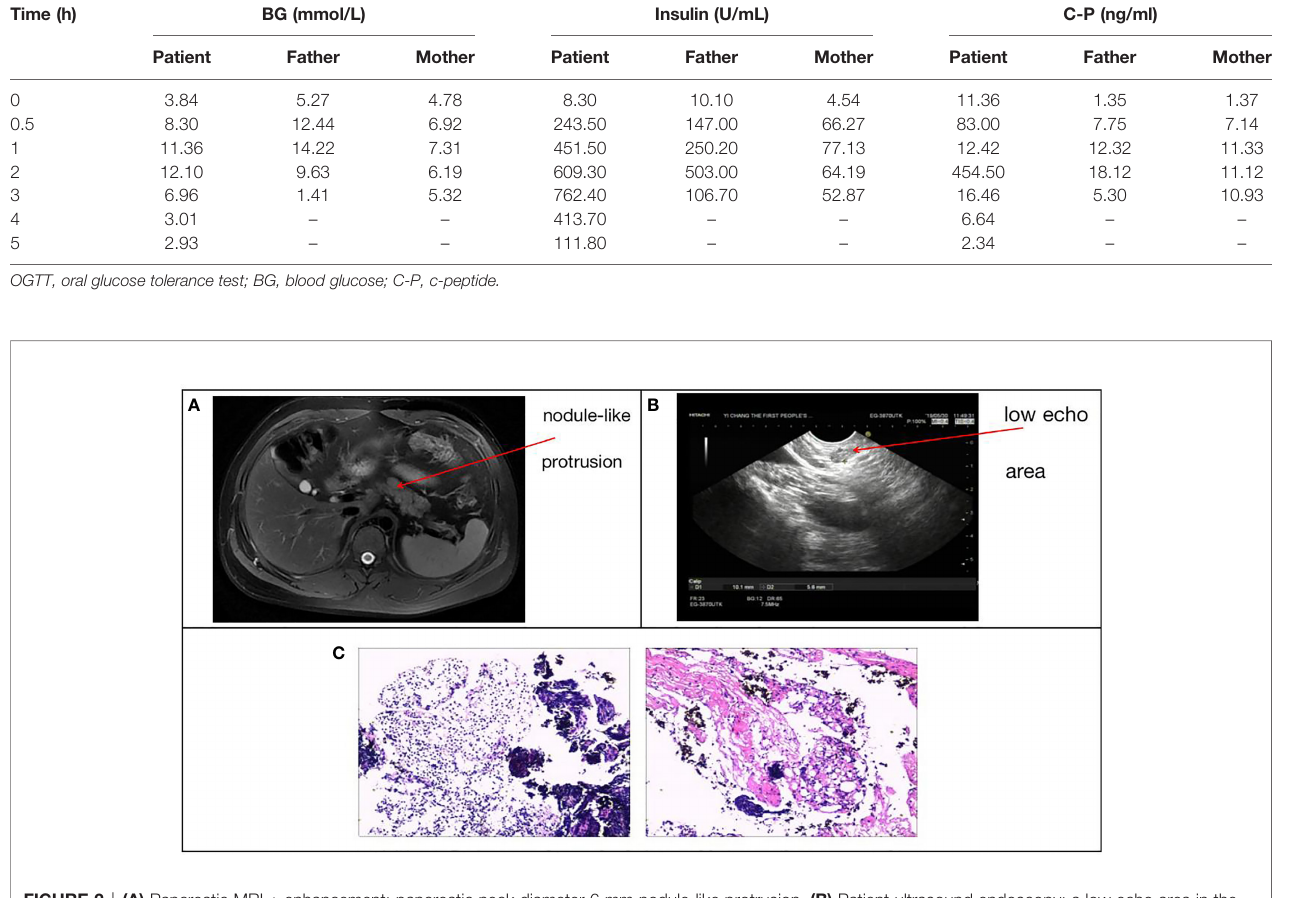
FIGURE 2 | (A) Pancreatic MRI + enhancement: pancreatic neck diameter 6 mm nodule-like protrusion. (B) Patient ultrasound endoscopy: a low echo area in the pancreatic neck with a sectional size of approximately 1.0*0.6 cm. (C) EUS-FNA, intraoperative pancreatic tissue disease showed pancreatic puncture tissue is mostly cellulose-like exudate, large lymphocytes and little eosinophils diffuse or focal in fi ltration, local extrusion deformation, structure under clear, no pancreatic tissue structure and other were